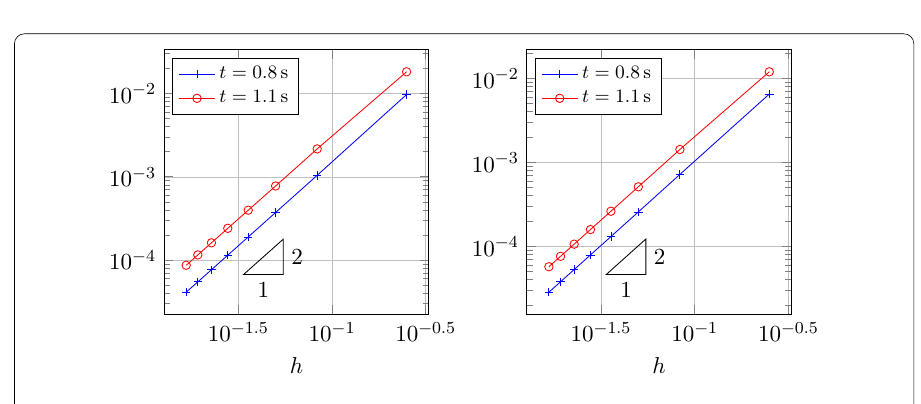
Fig. 9 Convergence of scheme (QIP) w.r.t. the space step h , for final time t = 0 . 8s, t = 1 . 1s for a heterogeneous transversely isotropic material. Left: Relative L 2 ( L 2 ( Ω ))-error on the displacement. Right: Relative L ∞ ( L 2 ( Ω ))-error on the displacement